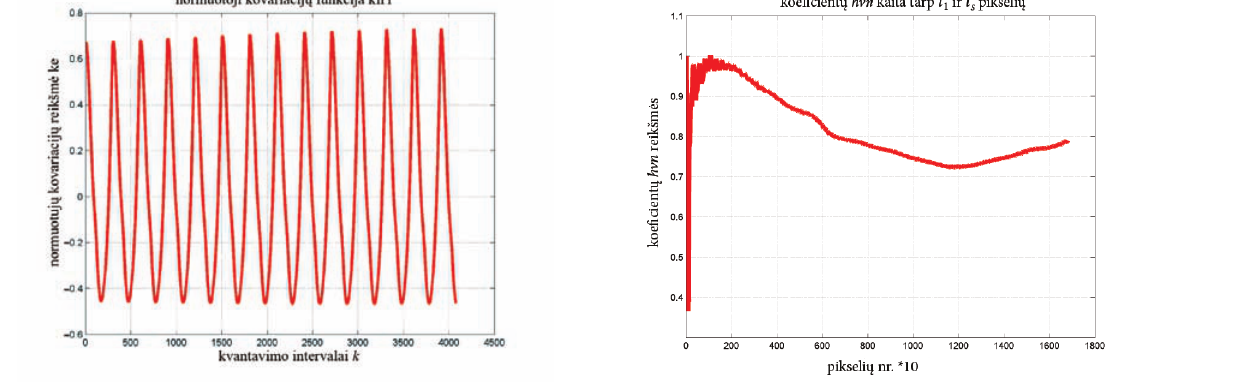
Fig. 6. The interrelation of normalized covariance function of digital images for the lenses of the eye with contact lenses